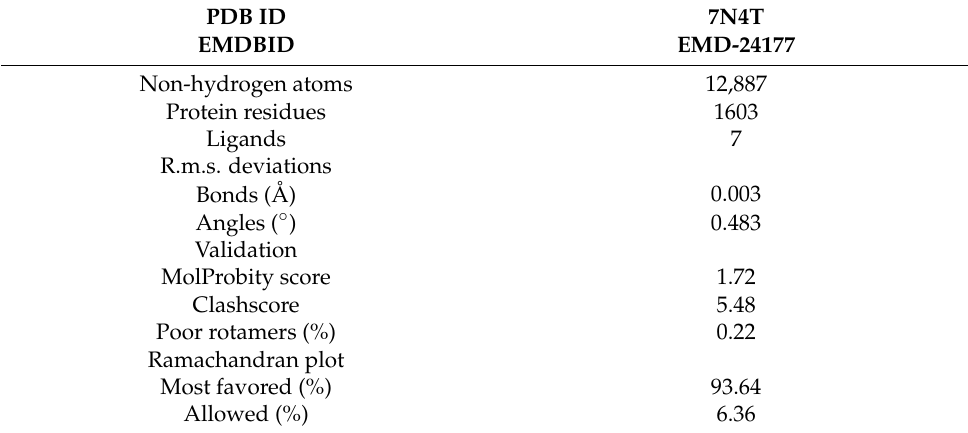
Table 2. Structure refinement and validation